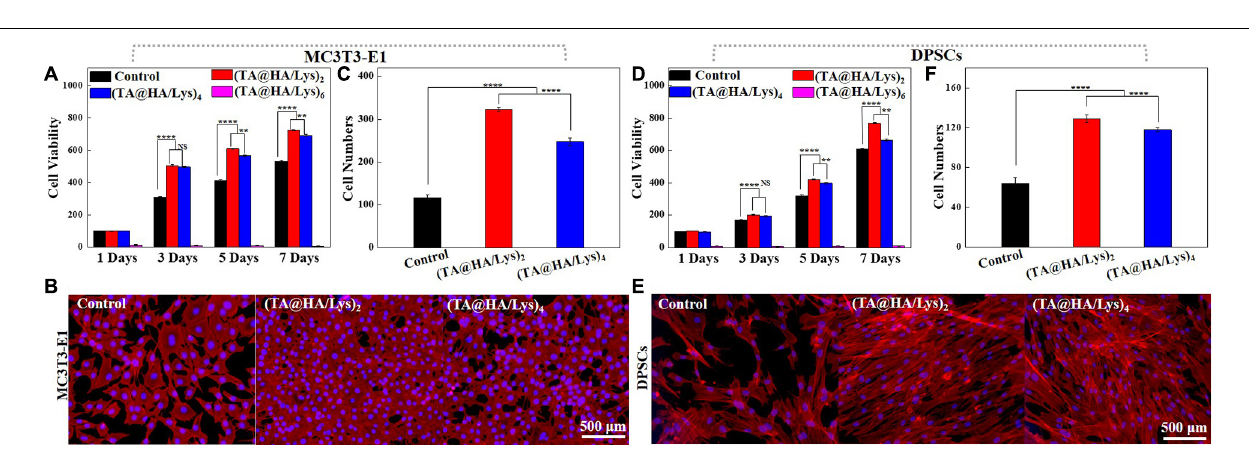
FIGURE 3 | SEM images of (A) (TA@HA/Lys) 2 , (B) (TA@HA/Lys) 4 , and (C) (TA@HA/Lys) 6 , and the corresponding magnified images in the insets of the upper right. (D) Surface roughness calculated from the atomic force microscope (AFM) images of (TA@HA/Lys) 2 and (TA@HA/Lys) 4 coatings, the insets are the corresponding AFM images. The scale bars in (A–C) are 20 µ m (200 nm in the insets). The scale bar in (D) is 2 µ m.